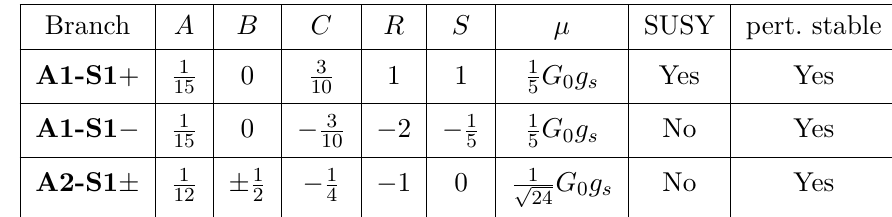
Table 2 . Different branches of S1 solutions found in [16], beyond the smearing